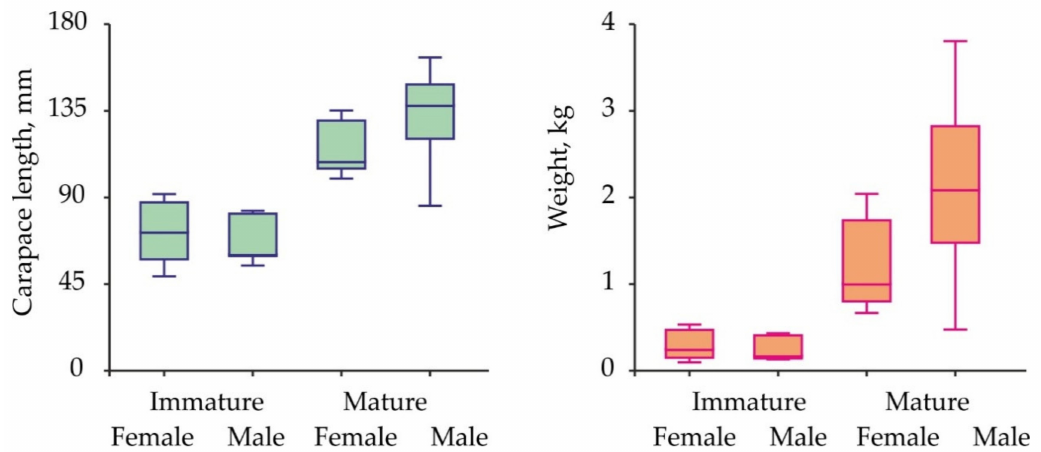
Figure 2. Carapace length and weight variations in the Barents Sea red king crabs analyzed for sex hormones.